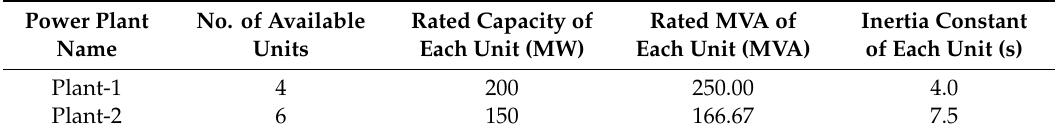
Table 1. Nameplate data of conventional power